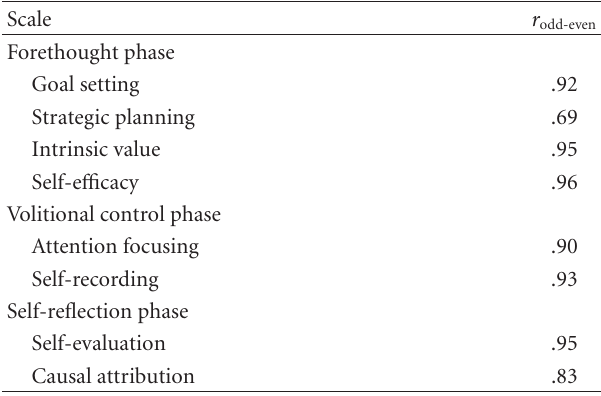
Table 4: Split-half reliabilities of diary scales, evaluated with the odd-even